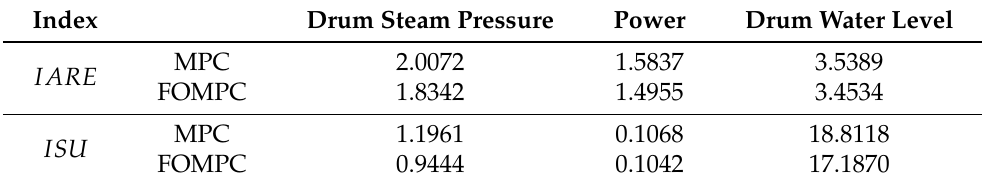
Table 4. Performance indexes for IARE and ISU in the power reference tracking experiment.